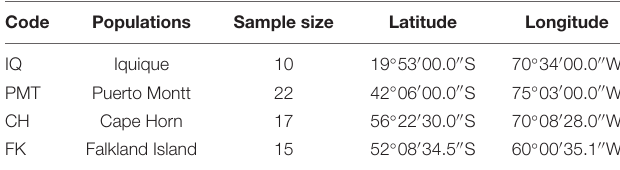
TABLE 1 | Geographical coordinates and number of individuals sampled in four Patagonian toothfish